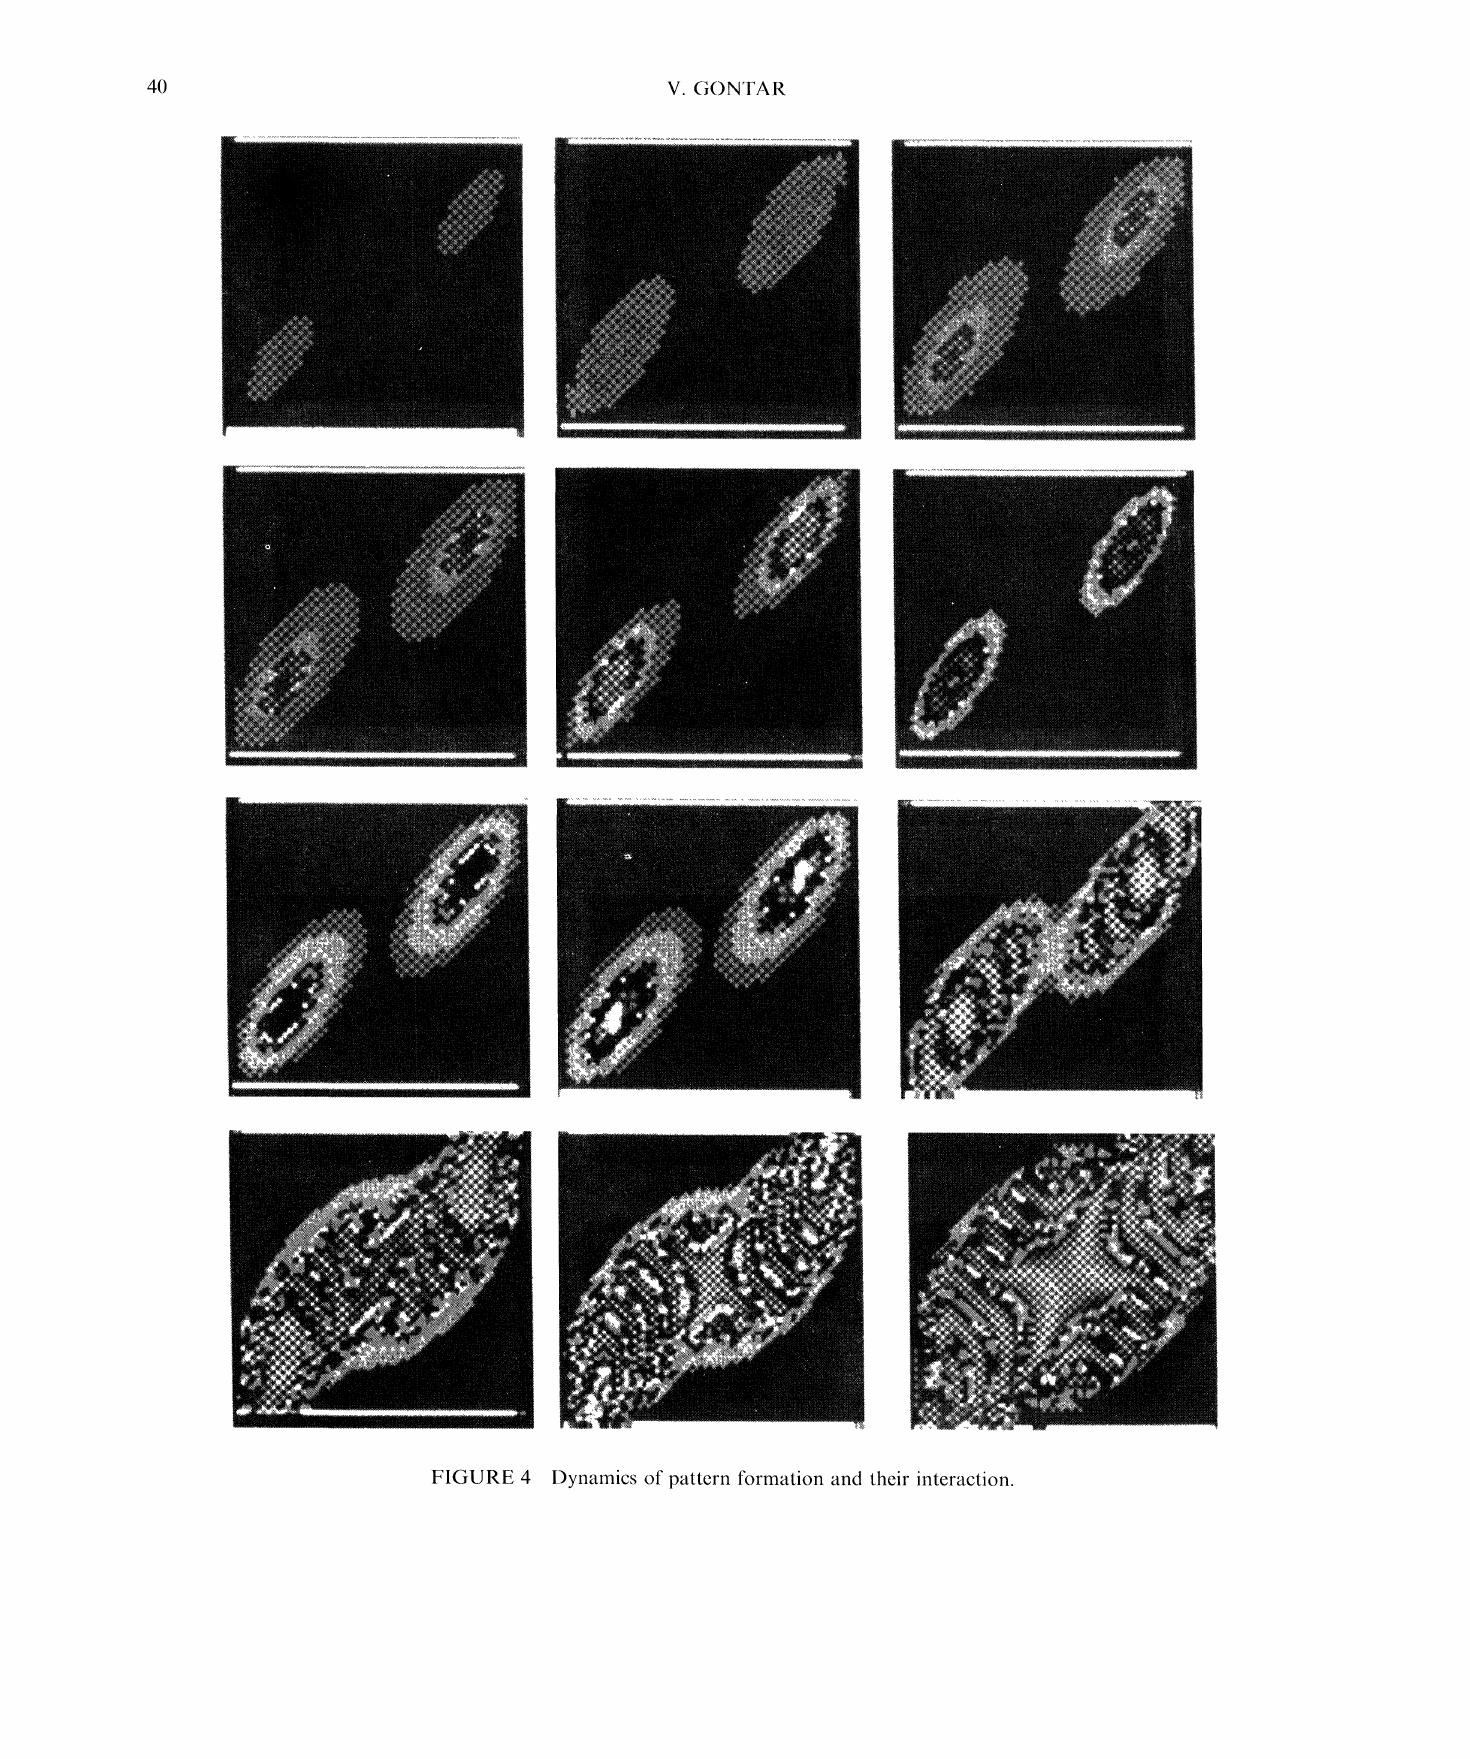
FIGURE 4 Dynamics of pattern formation and their